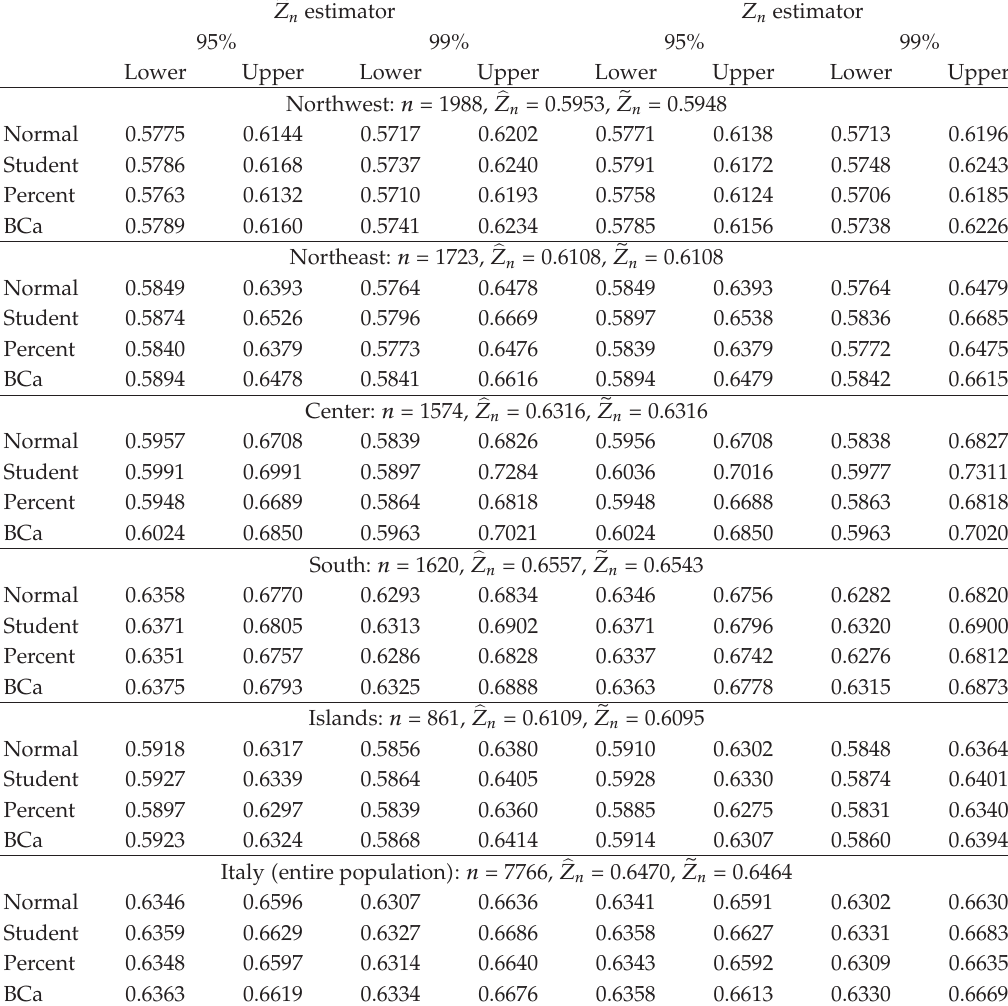
Table 3: Confidence intervals for Z F in the 2006 Italian income distribution. (cid:9) Z n